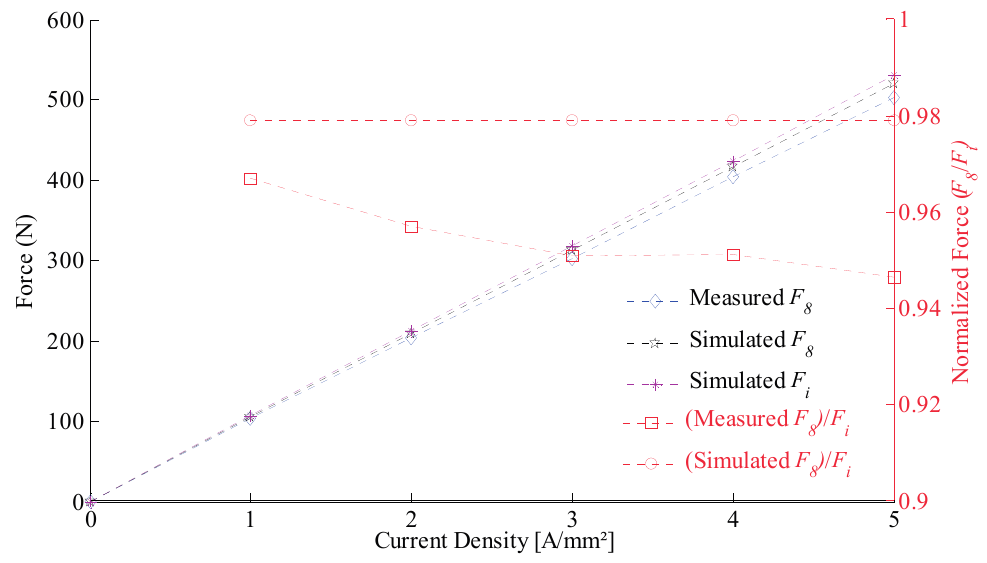
) and 8 ) and for an actuator i ). Normalized 8